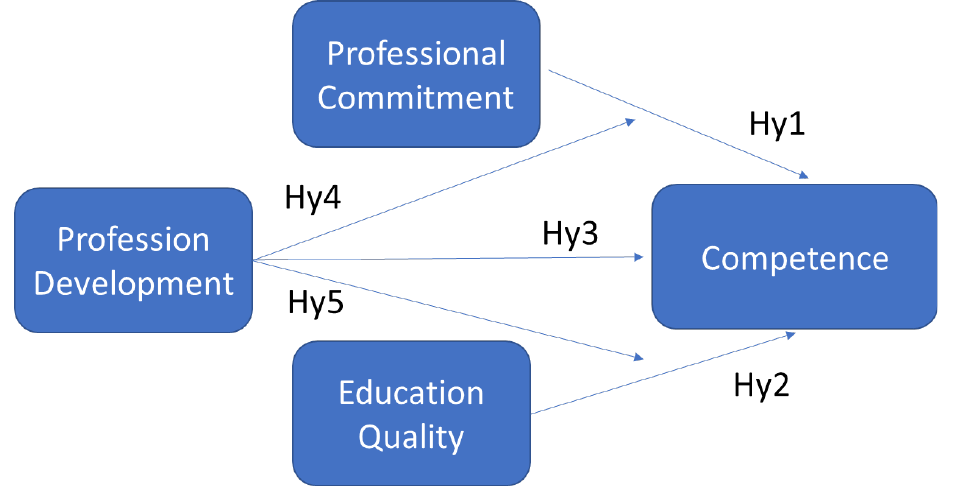
Figure 1 . Conceptual